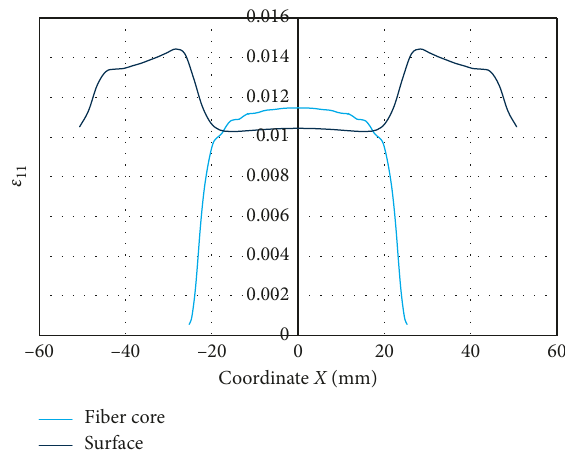
Figure 6: Strain value ε 11 in case when the fiber is located on the composite ply and attached to the surface through the adhesive layer.